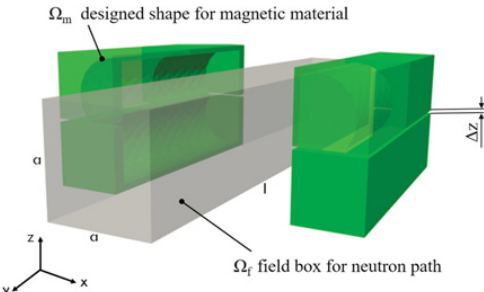
Figure 3. Magnet design after topology optimization. The action κ is adjustable by the gap size (cid:5) z .